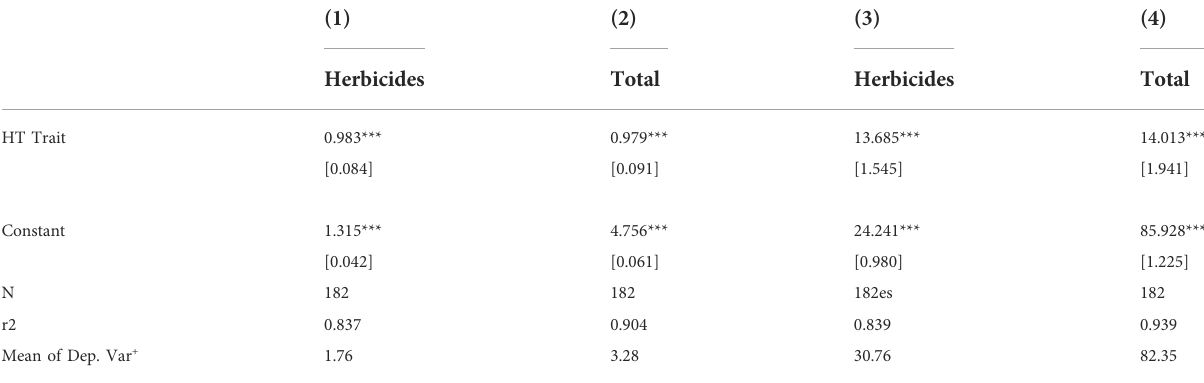
TABLE 2 Effect of HT trait on quantity and fi eld EIQ of herbicides and total pesticides.